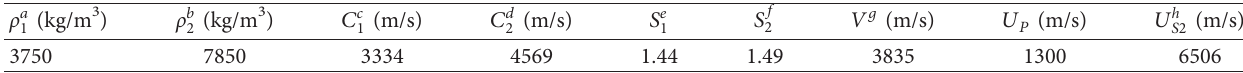
Table 4: Values of the impact parameters.